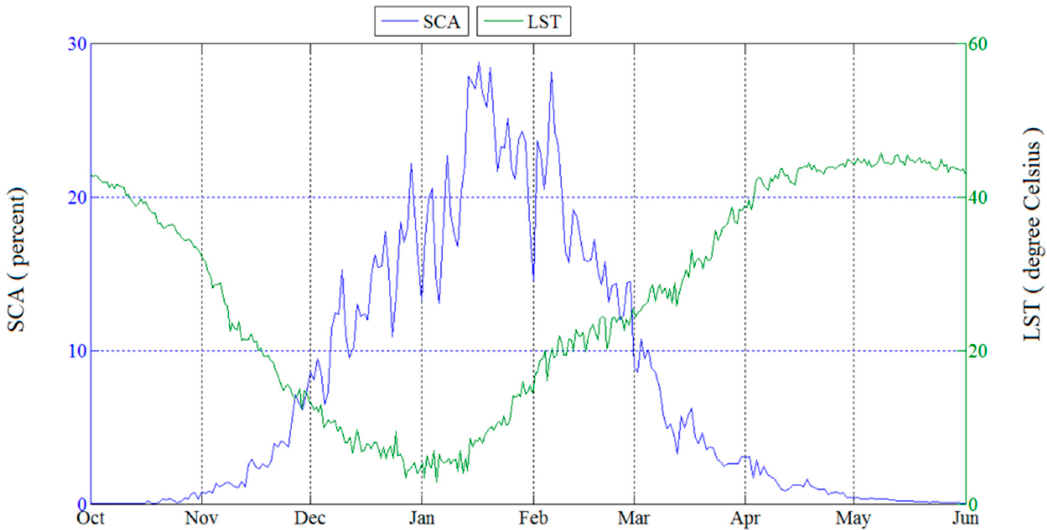
Figure 6. Seasonal evolution of the mean daily SCA and LST over the period 2003–2015.